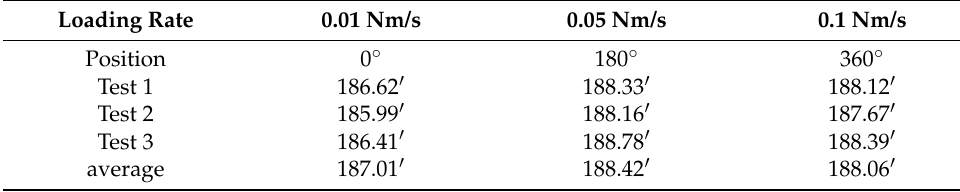
Table 8. Experiment results of δ g .